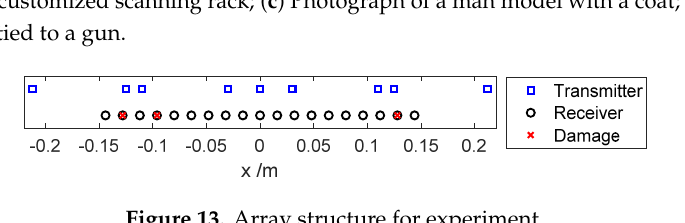
Figure 13. Array structure for experiment.